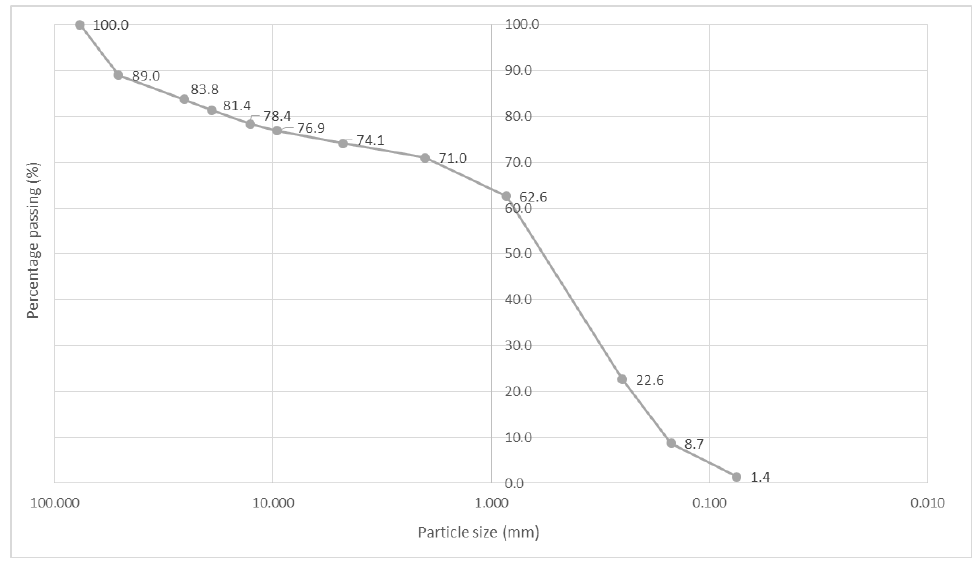
Figure 5. Particle size distribution